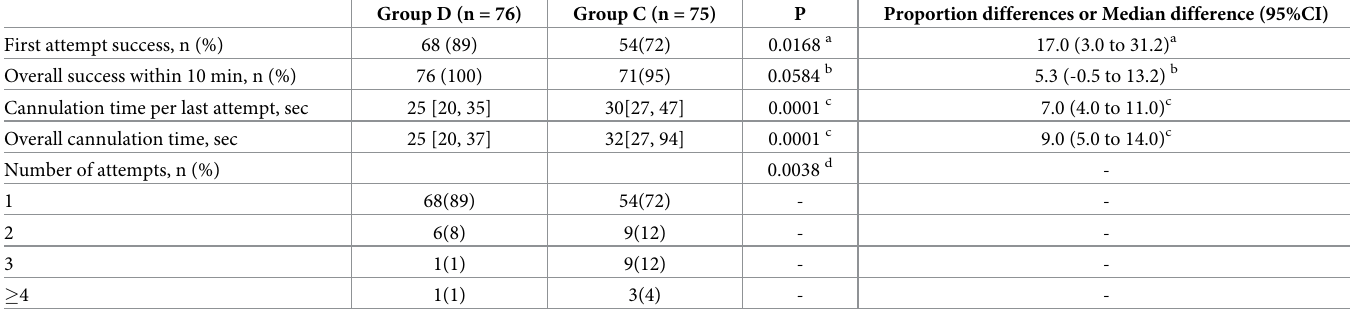
Table 2. Study results.